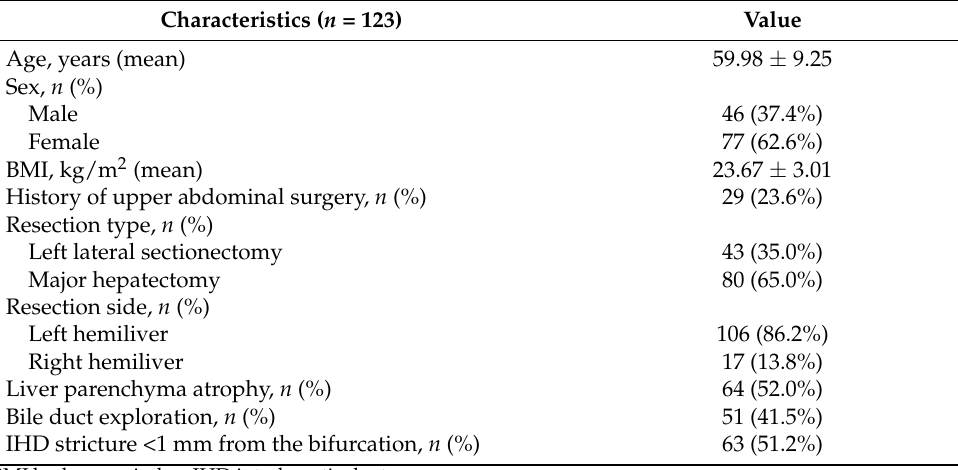
Table 1. Preoperative characteristics.